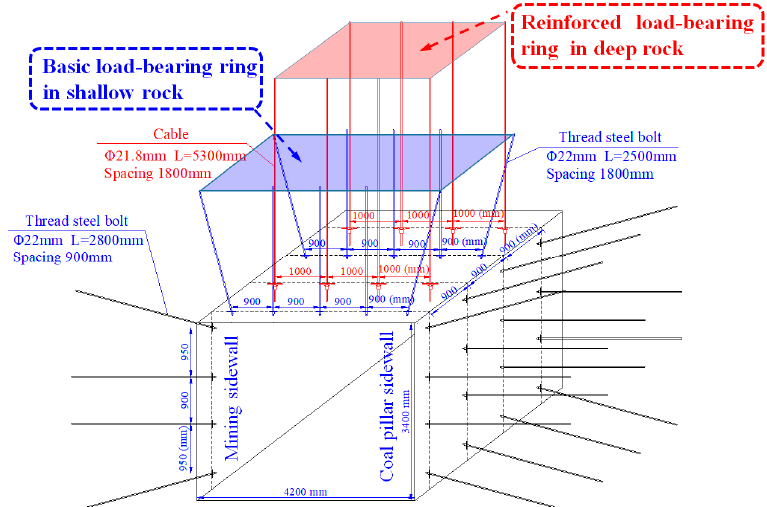
Figure 9. Supporting technical scheme.